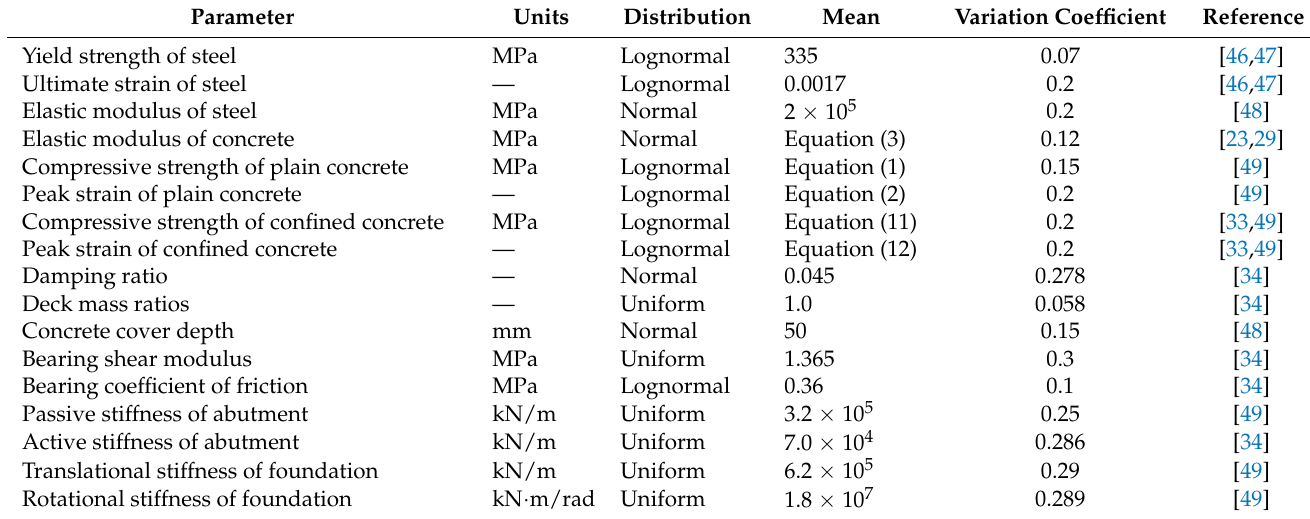
Table 2. Statistical data of the considered random variables.